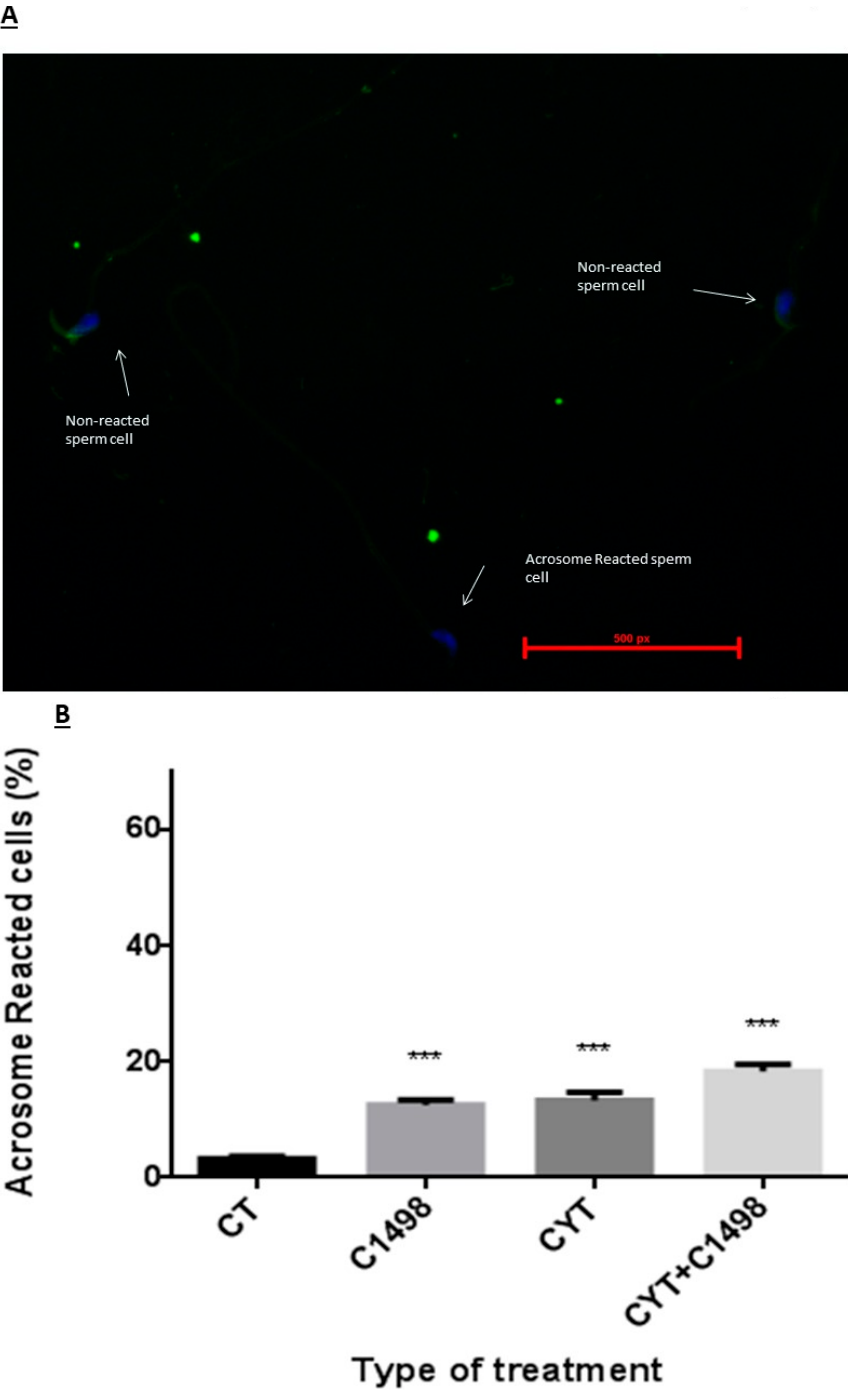
Figure 5. Effect of AML cells, cytarabine, and the combination of both compared to control (CT) on sperm spontaneous acrosome reaction: Mice were treated as described in Figure 1. Three weeks post-treatment, sperm were extracted from the epididymis and stained by fluorescein (FITC) staining ( A ). Acrosome reacted (without green staining) and non-reacted sperm (with green staining) were counted (A), and the percent of sperm that underwent spontaneous acrosome reaction was calculated ( B ). The results are representative of three independent experiment with four mice in each group. * Significant compared to control. *** p < 0.001.